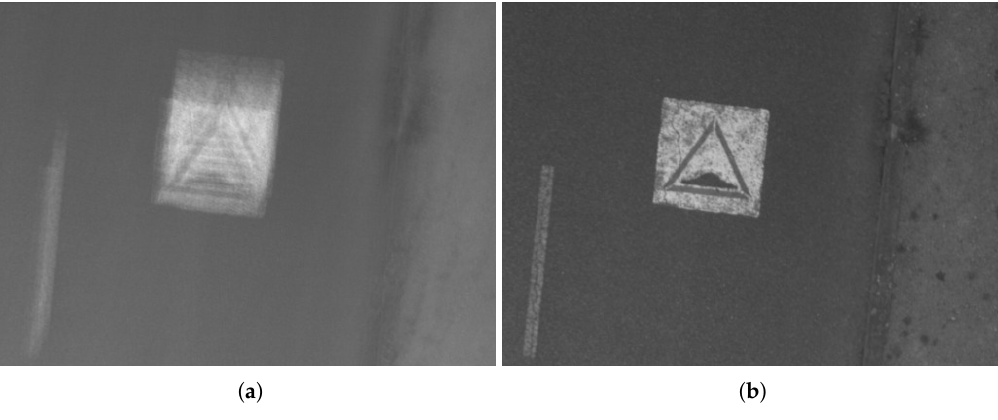
Figure 20. Example illustrating two subsections of two images. ( a ) is obtained by the average of the ten images; ( b ) is the stacked image. The angular motion between images is 1.2 degrees corresponding to 59